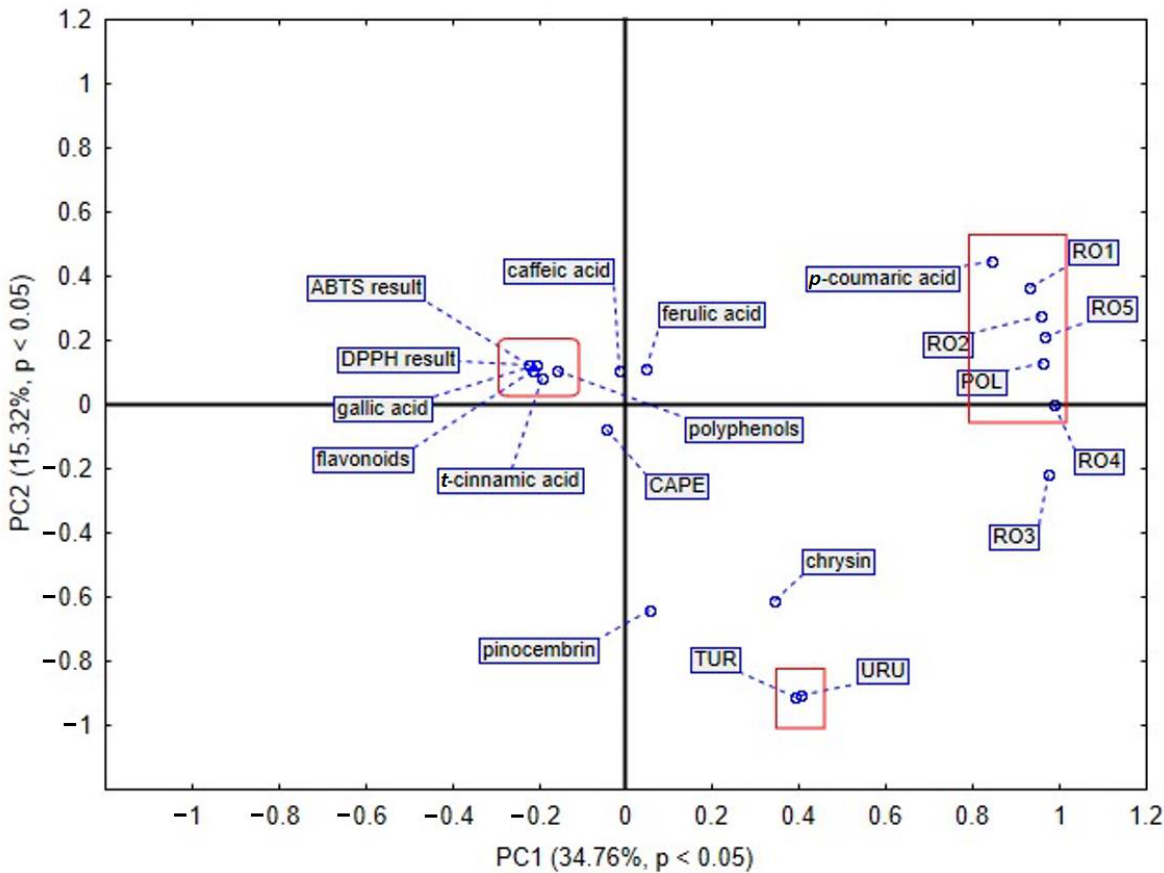
Figure 6. PCA score plot obtained by analysis of propolis of different origin. This PCA was based on analysis of different propolis samples analyzed in terms of the total amount of detected bioac- tive compounds.